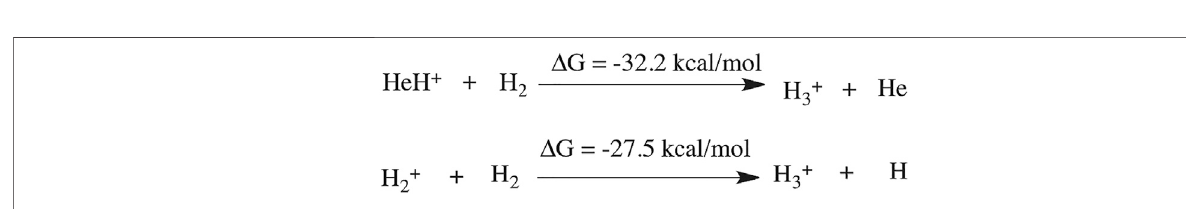
FIGURE 1 | Snapshots of AINR simulations showing the progress of the dynamics starting from atomic He and H, leading toward the formation of H 3+ from HeH + and dihydrogen. HeH + was seen to be formed very early – near the beginning of the dynamics (Color: He - peach, H - white).